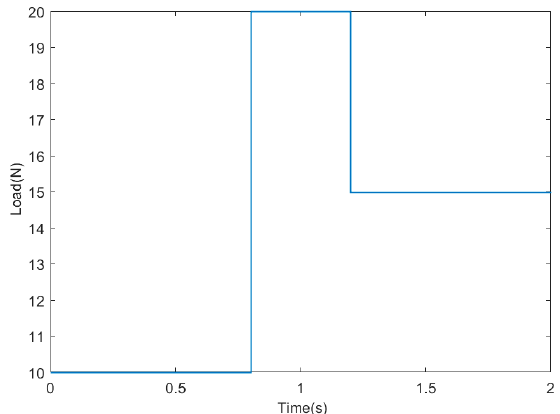
Figure 6. Load variation curve.